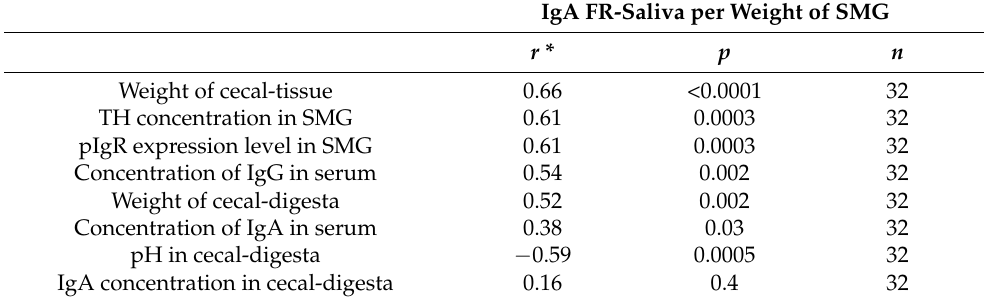
Table 2. Correlation between IgA flow rate of saliva (IgA FR-saliva) per weight of submandibular gland (SMG) and different parameters.